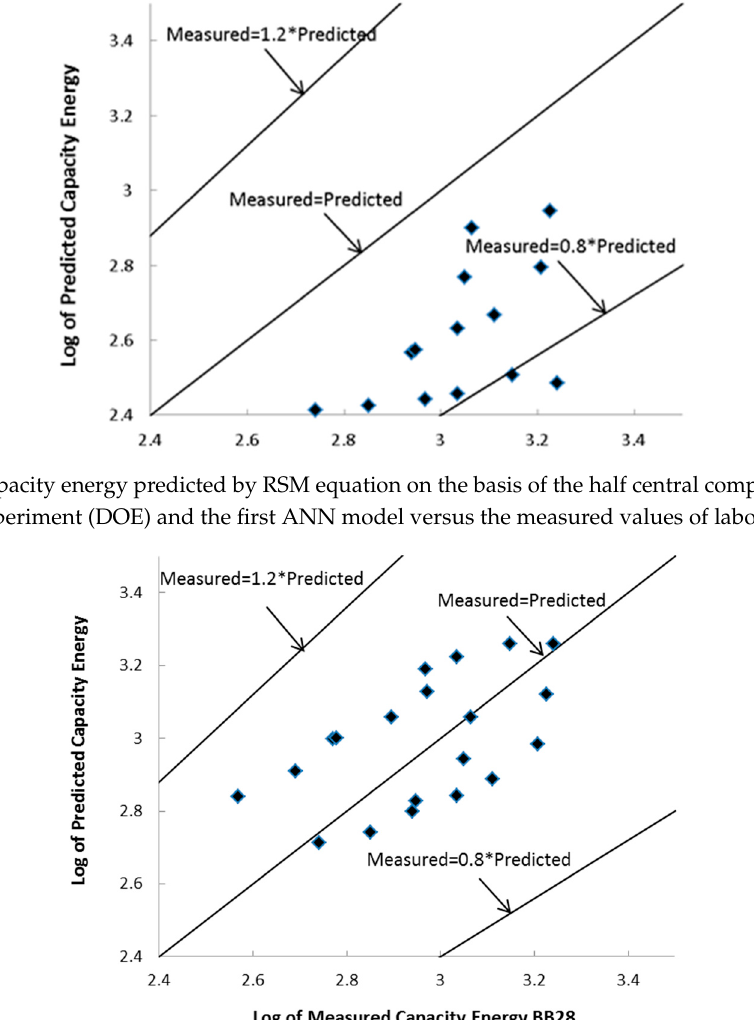
Figure 3. Capacity energy predicted by RSM equation on the basis of the central composite (CC) design of experiment (DOE) and the first ANN model versus the measured values of laboratory tests.